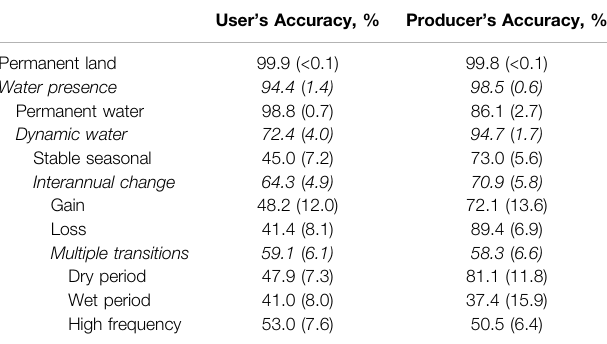
TABLE 8 | Accuracies of interannual dynamics of surface water for 1999 – 2018, where italicized classes represent aggregations of the classes below.